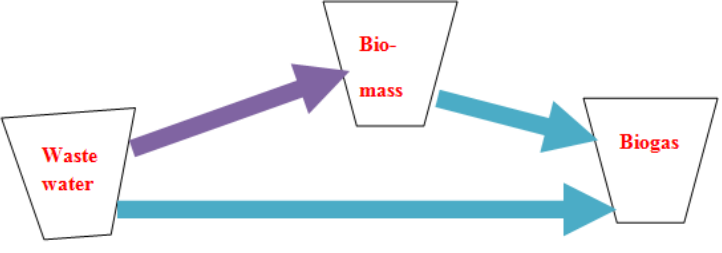
Figure 2. The possible route to biogas production during biological wastewater treatment.